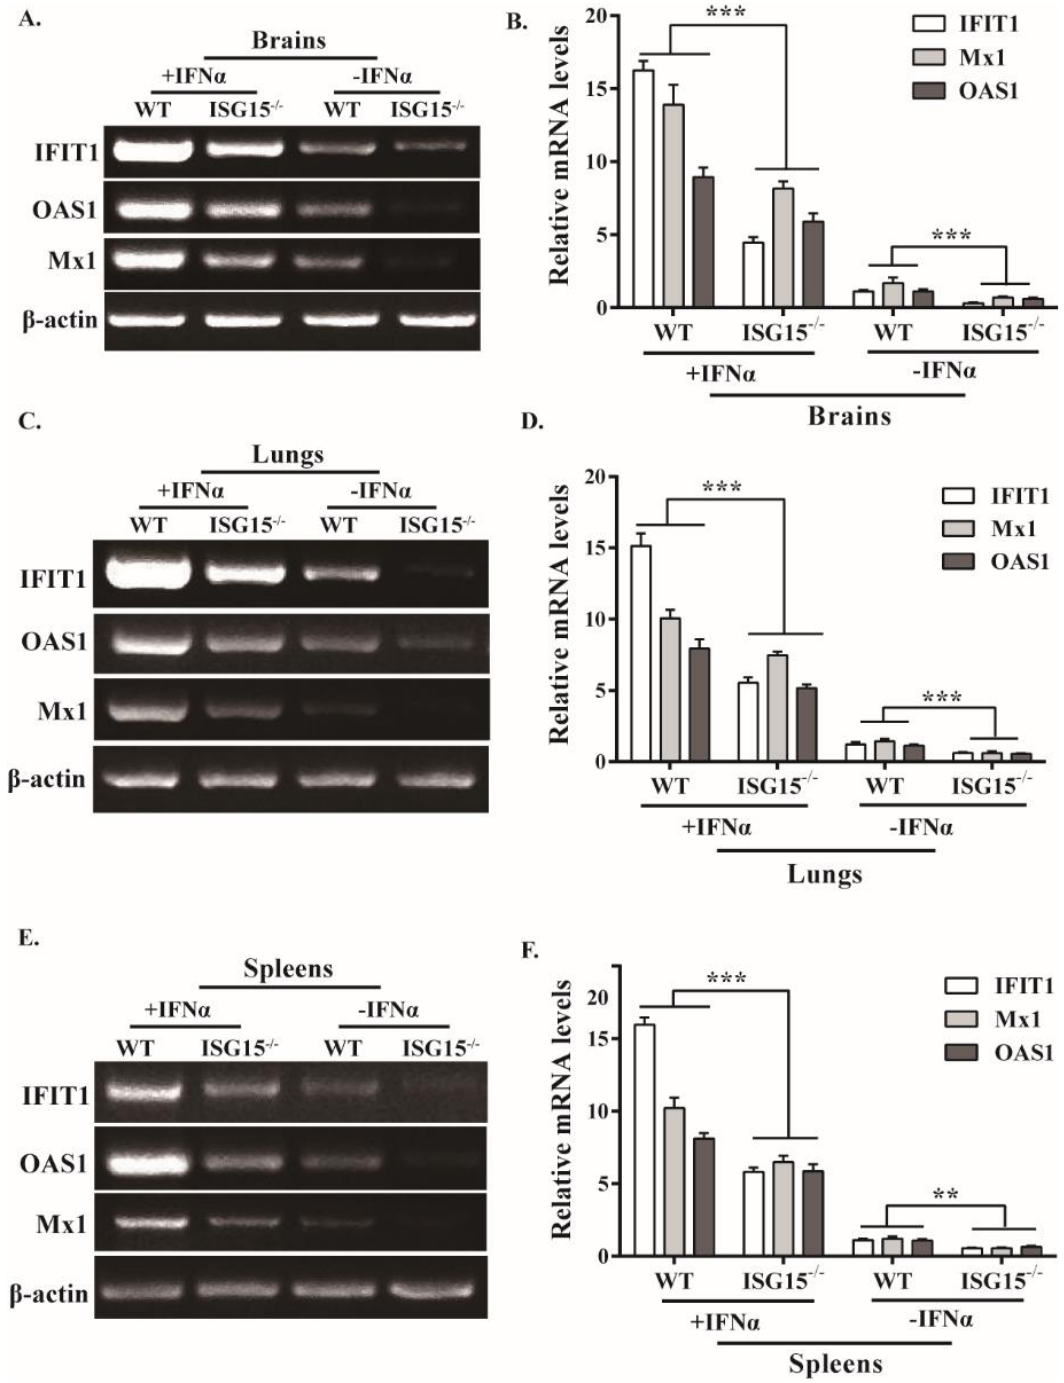
Figure 4. Several ISGs mRNA levels are downregulated in infected ISG15 -/- mice. WT and ISG15 -/- mice were intraperitoneally infected with PRV and pretreated or untreated with IFN α . At 4 dpi, the mRNA levels of IFIT1, OAS1 and Mx1 in brains ( A ), lungs ( C ) and spleens ( E ) of infected mice were examined by RT-PCR and RT-qPCR ( B , D , F ), respectively. ** p < 0.01; *** p < 0.001.